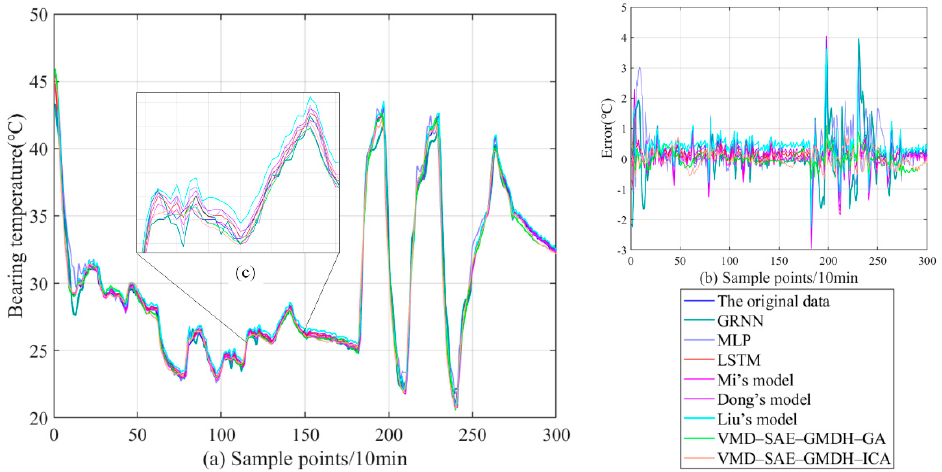
Figure 5. Forecasting results and errors of all models of series #1: ( a ) forecasting results; ( b ) error distribution; ( c ) local enlargement.